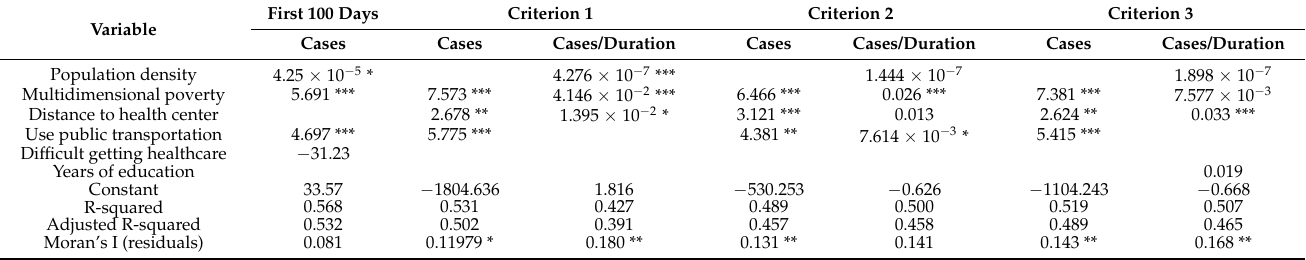
Table 2. OLS regression under different scenarios: case rate.